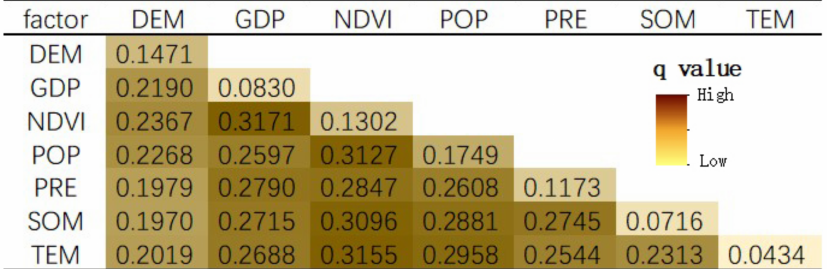
Figure 6. The impact of single-factor and two-factor interaction on the ESV variation. DEM is the digital elevation model, GDP is the gross economic product, NDVI is the normalized difference vegetation index, POP is population density, PRE is precipitation, SOM is soil organic matter, and TEM is